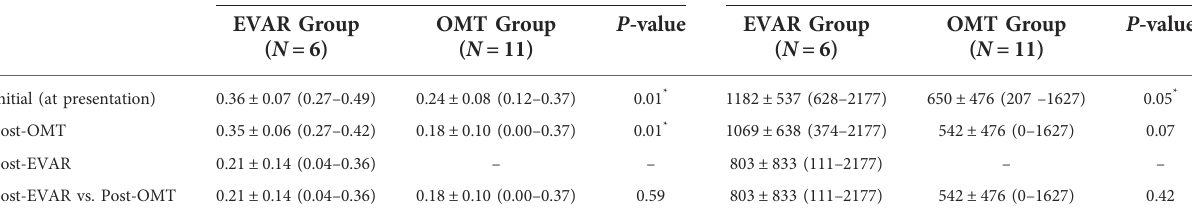
TABLE 3 Retro-peritoneal fi brosis (RPF) aortic index and cross-sectional area of the peri-aortic soft tissue enhancements at the initial diagnosis, post optical medical treatment (OMT) and post endovascular aneurysm repair (EVAR).